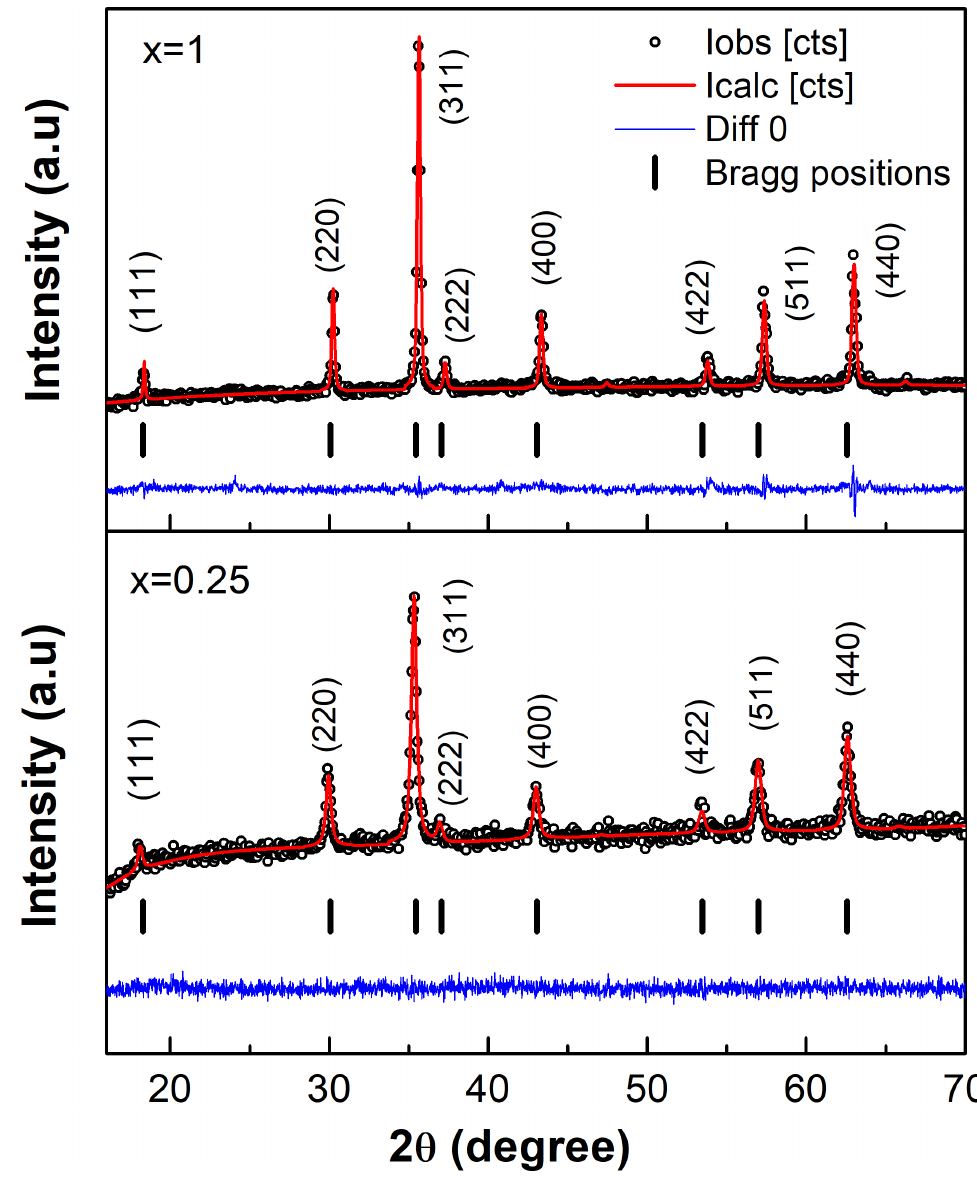
Figure 2. XRD powder pattern and Rietveld refinement of the Ni x Co 1 − x Fe 2 O 4 ferrites with x = 0.25 as a representative sample. The experimental data are represented by black circles, the calculated data by a red line, and the difference between the two by a blue line. Bragg positions are represented by black vertical